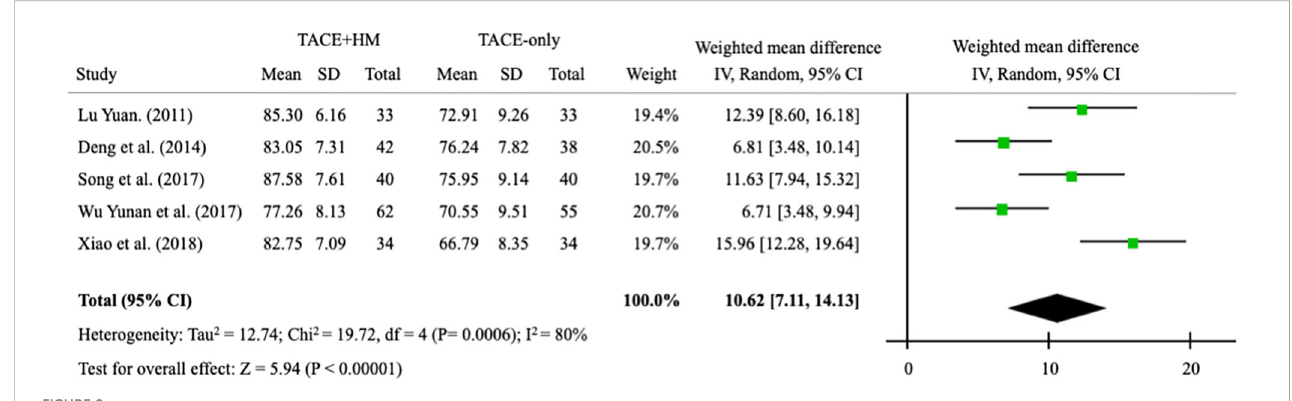
FIGURE 8 Meta-analysis of performance status (Karnofsky performance status